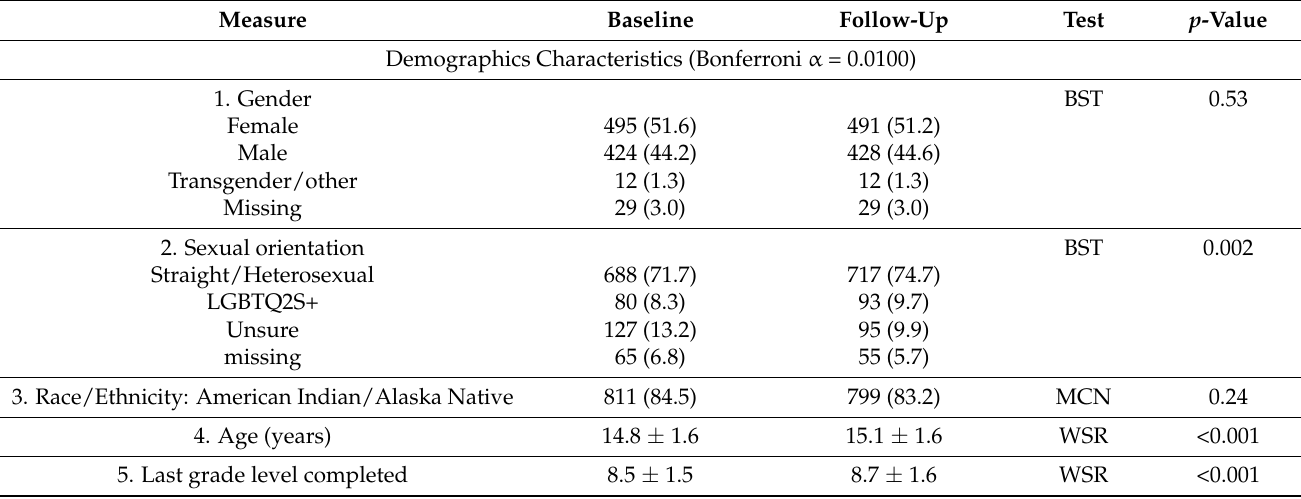
Table 1. Change from Baseline to Follow-up for Native STAND youth by survey subsection. Measure Baseline Follow-Up Test p -Value Demographics Characteristics (Bonferroni α =